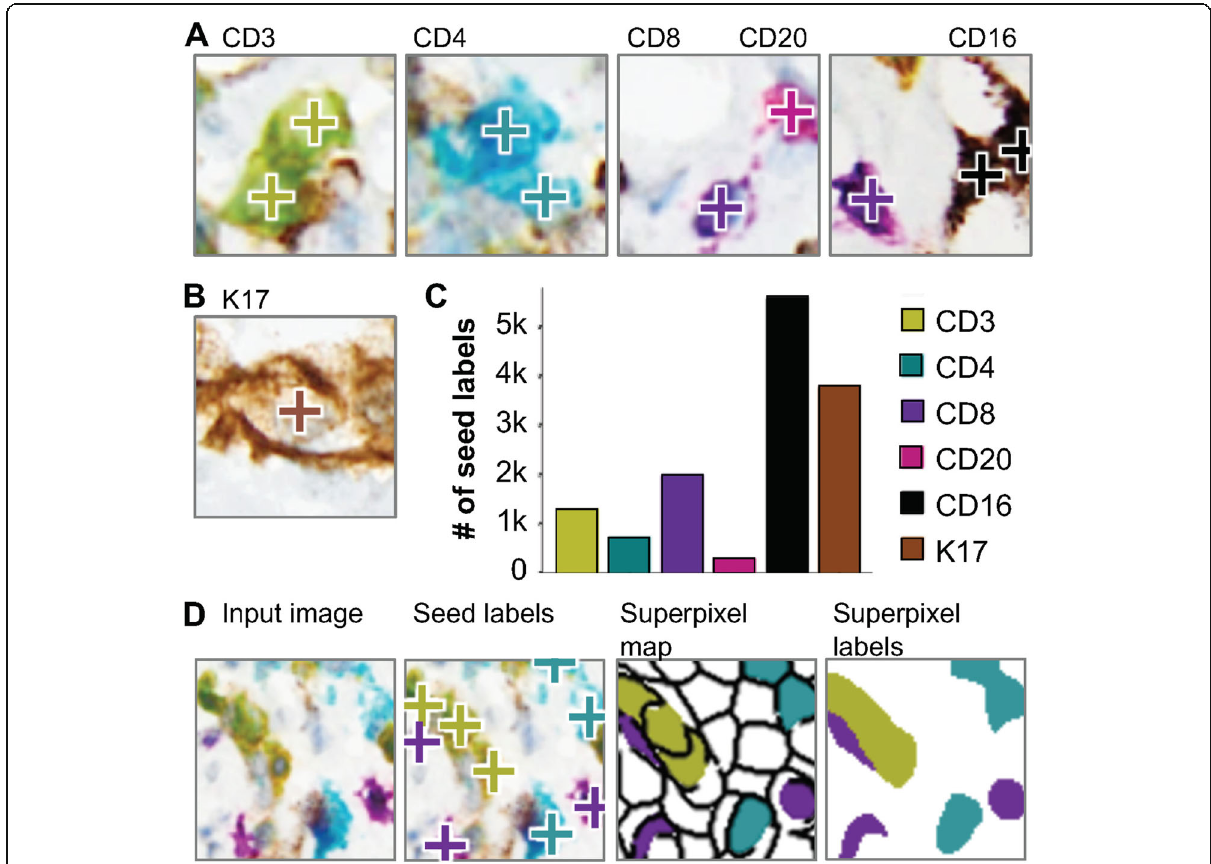
Fig. 2 Annotation of patches with seed labels and generation of per-pixel training data. a Examples of CD3+, CD4+, CD8+ and CD20+ lymphocytes, CD16+ myeloid cells and b K17+ PDAC tumor cells with seed labels overlaid (+). c Number of seed labels for each cell class, across all patches used for training. d Input image; input image with seed labels overlaid; superpixel map generated based on the input image, with superpixels containing different seed labels colored accordingly; and the superpixel labels used to train the models (based on seed labels and superpixel